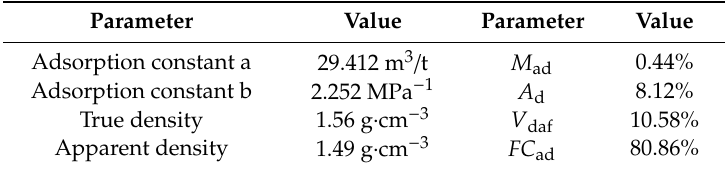
Table 1. Industrial analysis and basic parameters of coal